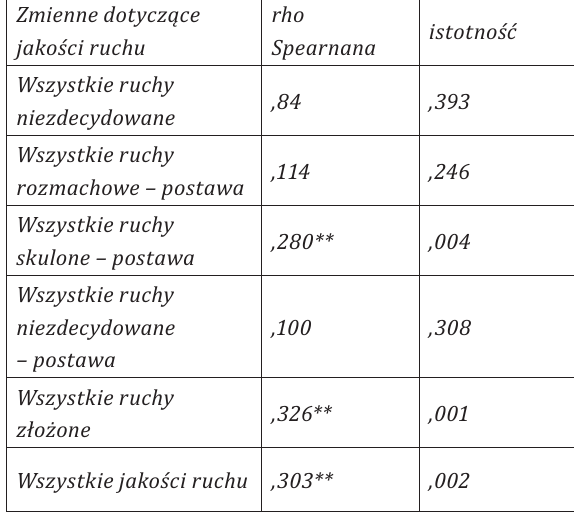
Tabela 7. Wartości rho Spearnana między zmienną „światłocienie” a zmiennymi dotyczącymi jakości ruchu Jak widzimy na podstawie danych zawartych w Tabeli 5., ojcowie chorych dzieci dali więcej wypowiedzi na tablicę X i wysoce istotnie częściej wykorzystywali do interpretacji plam światłocień. Liczba wypowiedzi